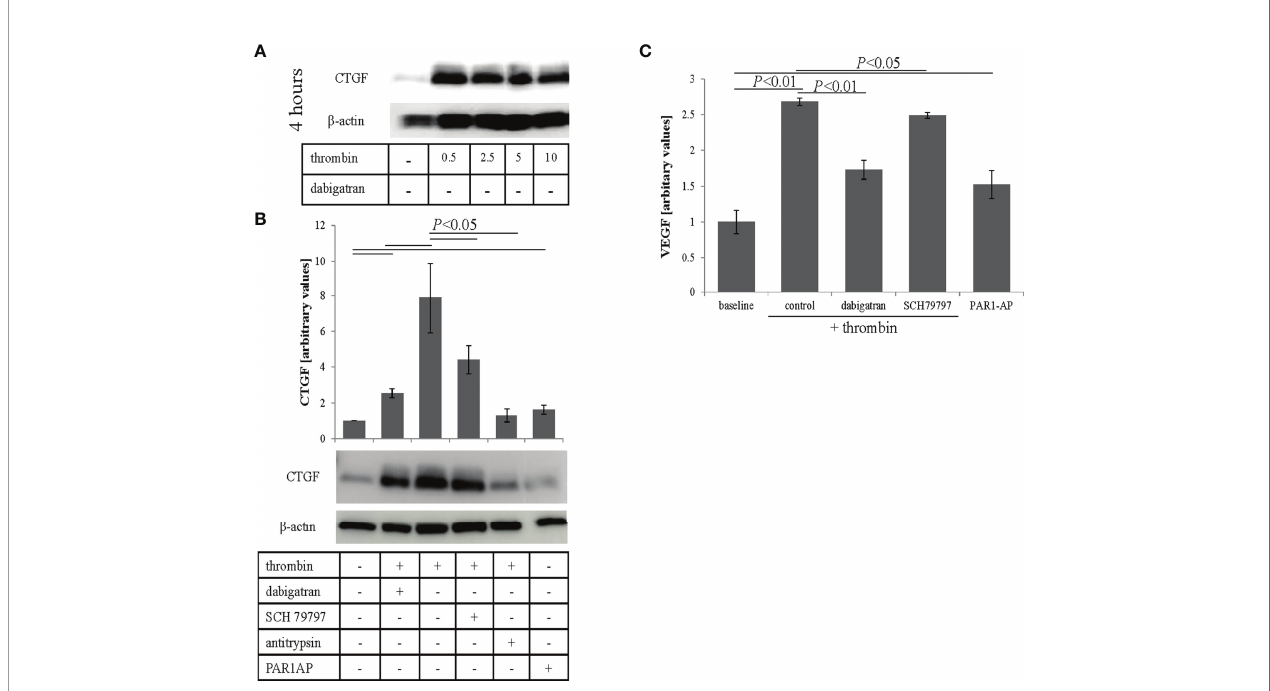
FIGURE 3 | Thrombin-mediated effects on CTGF and VEGF expression. (A) Cell lysates were analyzed for thrombin-mediated CTGF expression. Thrombin induced expression of CTGF, that was already maximal at 0.5 U/mL. (B) Densitometric analysis demonstrated that thrombin-induced CTGF expression could be reduced by dabigatran (10 m M), the protease activated receptor-1 (PAR1) receptor antagonist (SCH79797; 250 m M), and the non-speci fi c protease inhibitor ( a 1-antitrypsin; 1 mg/mL), and could be triggered using PAR1-AP (30 m M), a PAR1 agonist. (C) VEGF secretion (assessed by ELISA) into the apical supernatant could be induced by thrombin treatment and reduced by dabigatran and the selective non-peptide PAR1 receptor antagonist SCH79797. VEGF secretion into the apical supernatant could be triggered using the PAR1-AP. Data are plotted as mean ± SEM; n = 3 independent